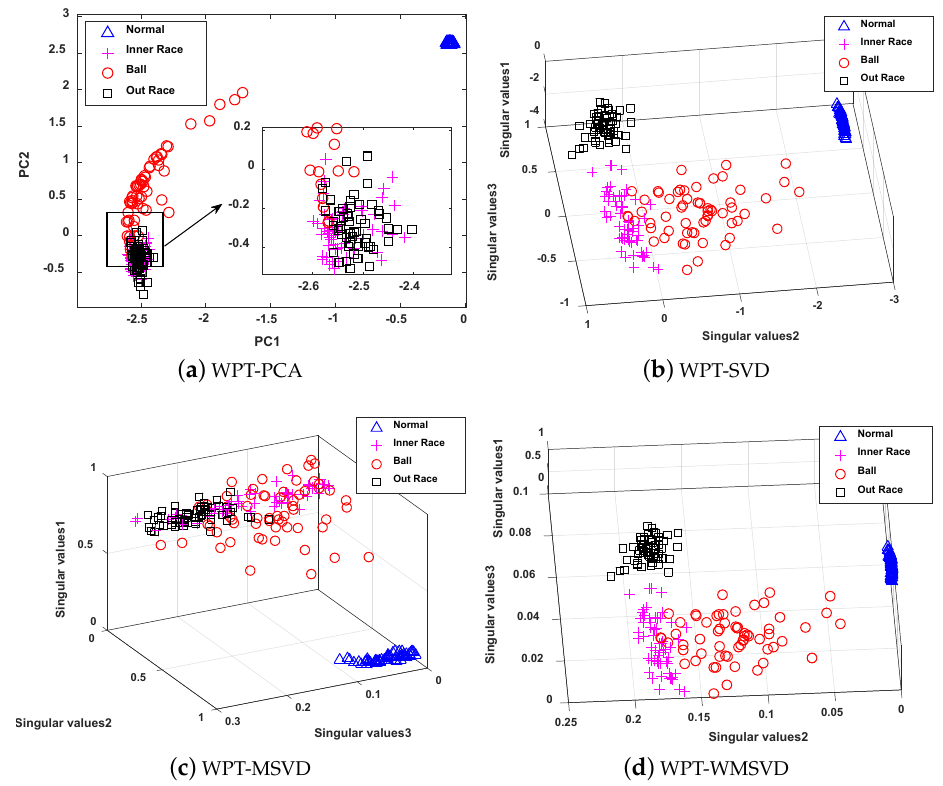
Figure 18. The Visualization of feature extraction effect of four methods under general faults: ( a ) Dis- tribution of the data samples based on WPT-PCA; ( b ) Distribution of the data samples based on WPT-SVD; ( c ) Distribution of the data samples based on WPT-WSVD; and, ( d ) Distribution of the data samples based on